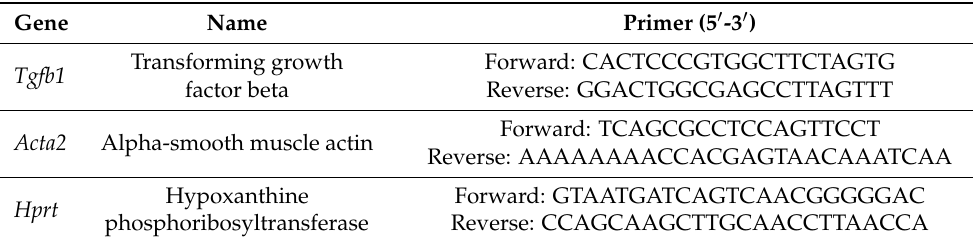
Table 1. Primer sequences for real-time PCR